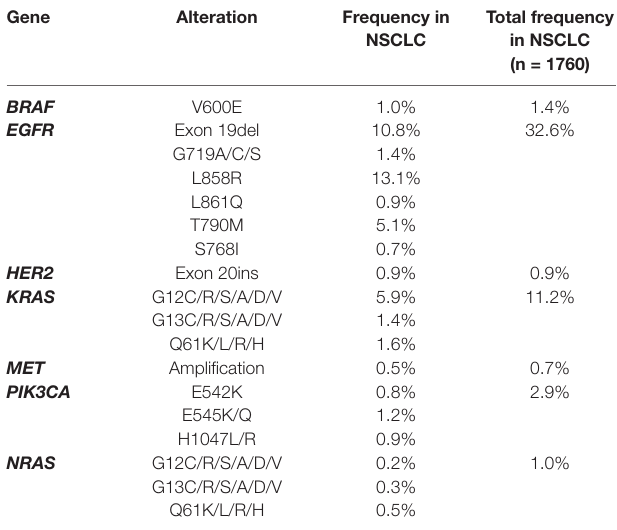
TaBLE 3 | Frequency of mutations in lung adenocarcinoma blood samples.